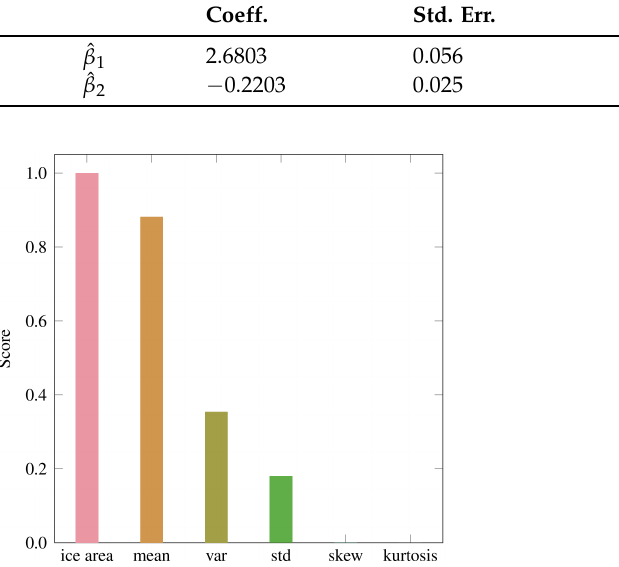
Figure 4. Feature ranking for statistical interpolation in sub-region No. 2.